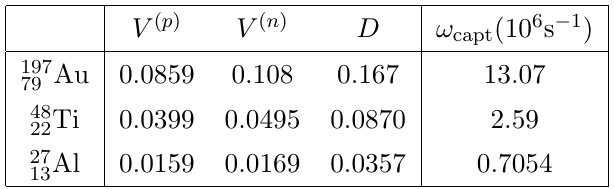
Table 5 . Overlap integrals in units of m 5 = 2 (cid:22) ( V ( p ) , V ( n ) and D ) and total capture rates ( ! capt ) for di(cid:11)erent nuclei [29]. The total capture rates are taken from table 8 in ref. [29]. The overlap integrals of 197 Au as well as 27 Al are taken from table 2 and the ones for 48 79 13 in ref.